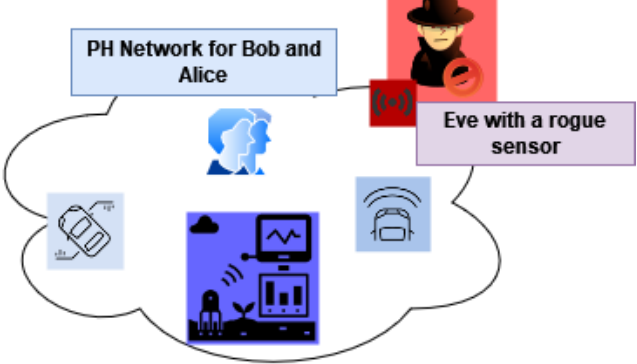
Figure 3. Scenario: Group User